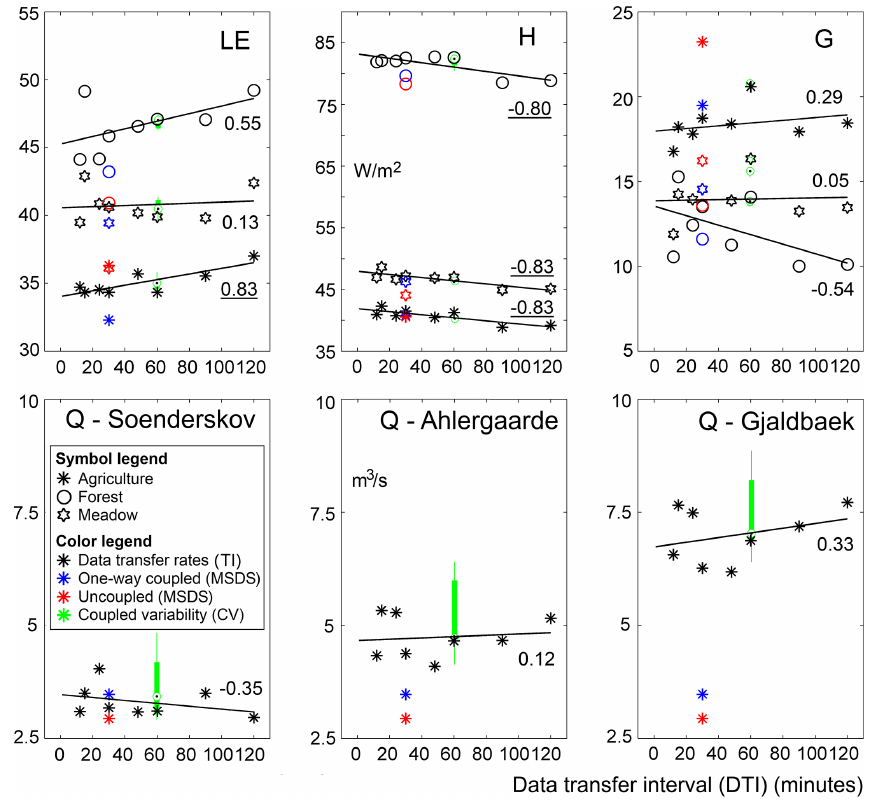
Figure 8. MIKE SHE output RMSE statistics for each of the three flux tower measurement sites and the three discharge stations for the TI, MSDS and CV simulations. For the TI simulations linear trend lines are shown with RMSE as a function of DTI as well as the average trend line correlation coefficients where significant correlations on a two-sided 95% confidence level are underlined. Also, the variability of the perturbed CV simulations is